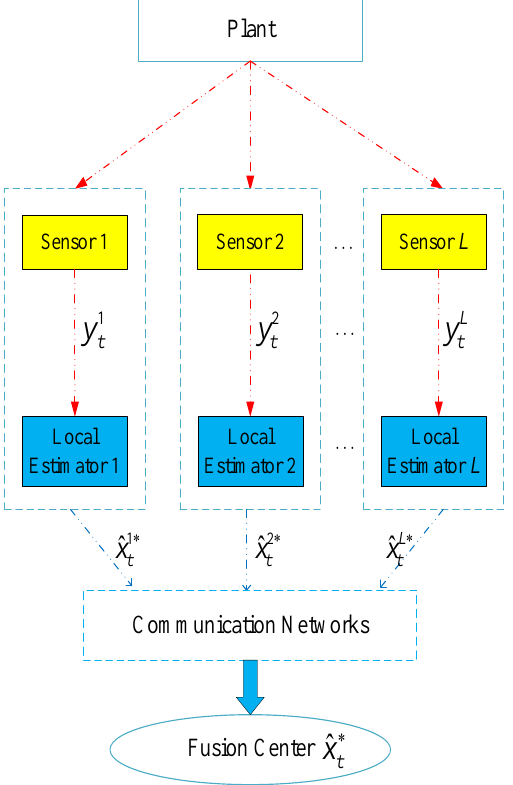
Figure 1. Distributed moving horizon fusion estimation